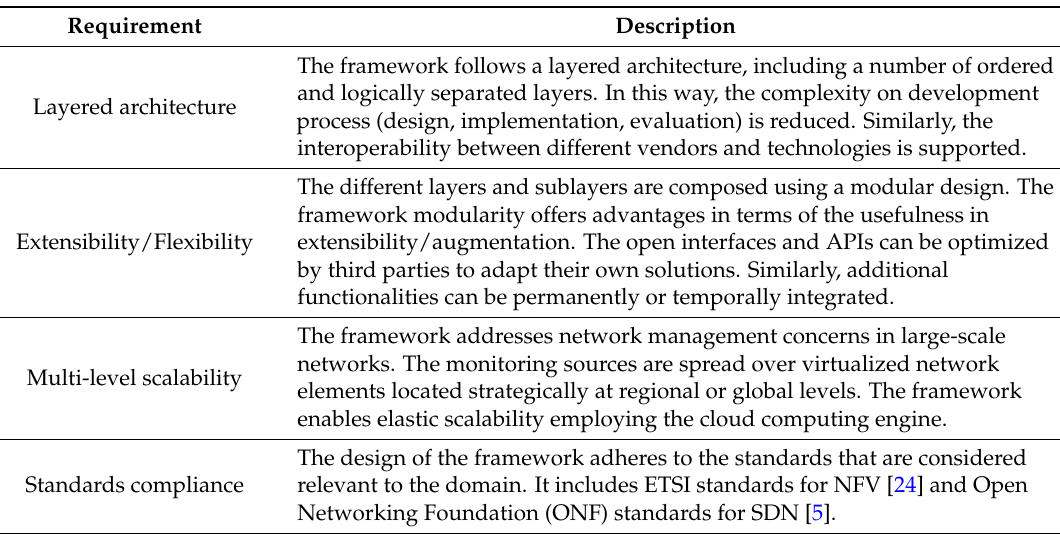
Table 3. Framework architectural